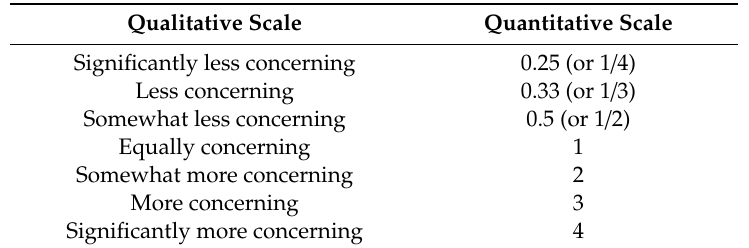
Table 6. Quantitative conversion scale used for the culvert failure risk assessment survey.